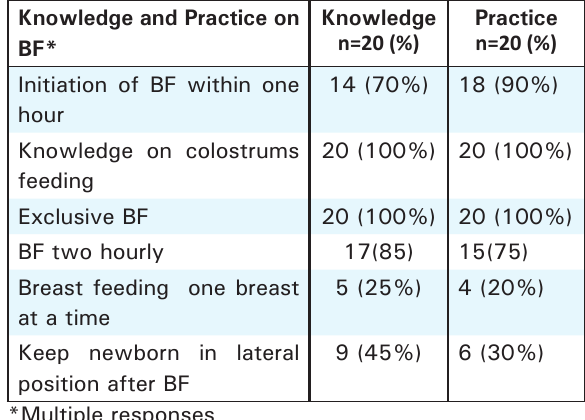
Table 7. Knowledge and Practice on Breast